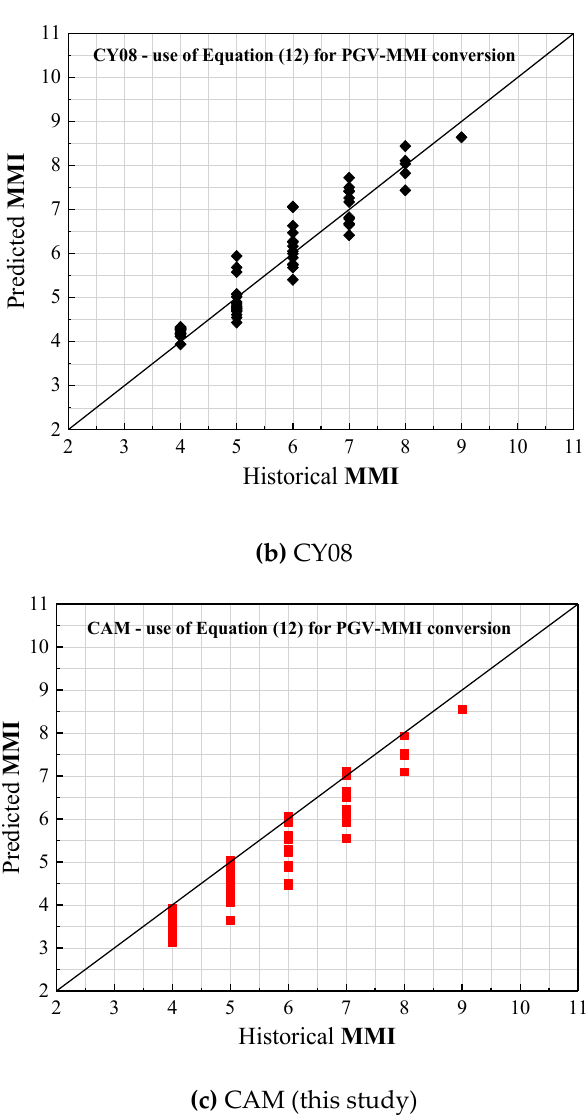
Figure 11. Comparison between historical recorded and model-predicted MMI for SEC.